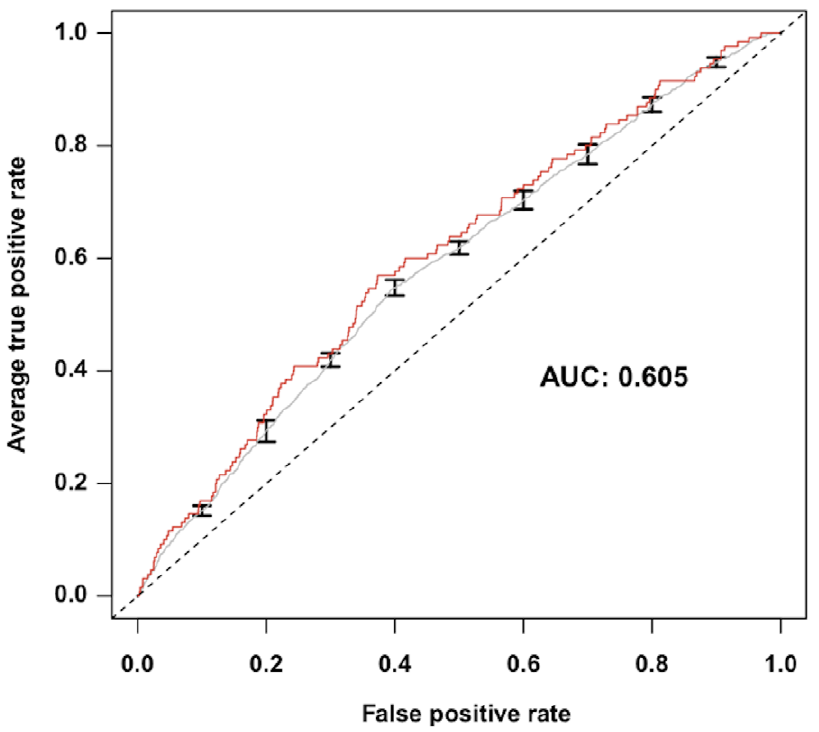
Figure 1. Receiver Operating Characteristic (ROC) curve. The ROC curve depicts the performance of our algorithm to identify known pain genes listed in the Pain Genes Database [18]. The area under the ROC curve is 60.5%, which is significantly different from random chance. Maximum sensitivity and specificity are 56.9% and 62.7% respectively.